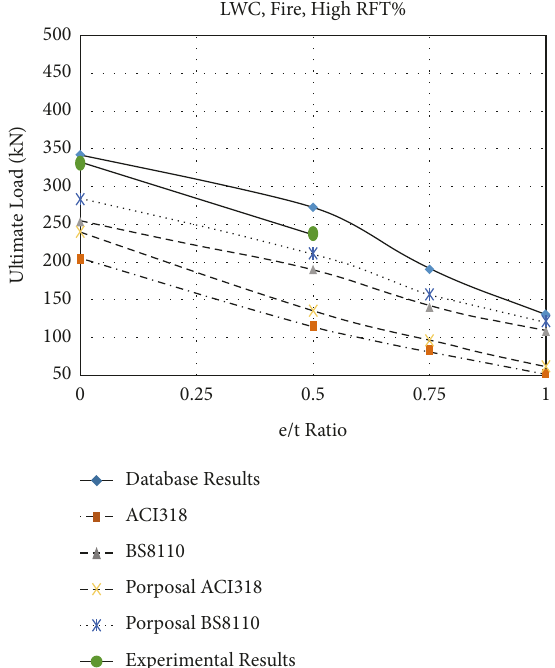
Figure 15: Comparison of fired LWC database-ultimate loads and different codes using the proposal